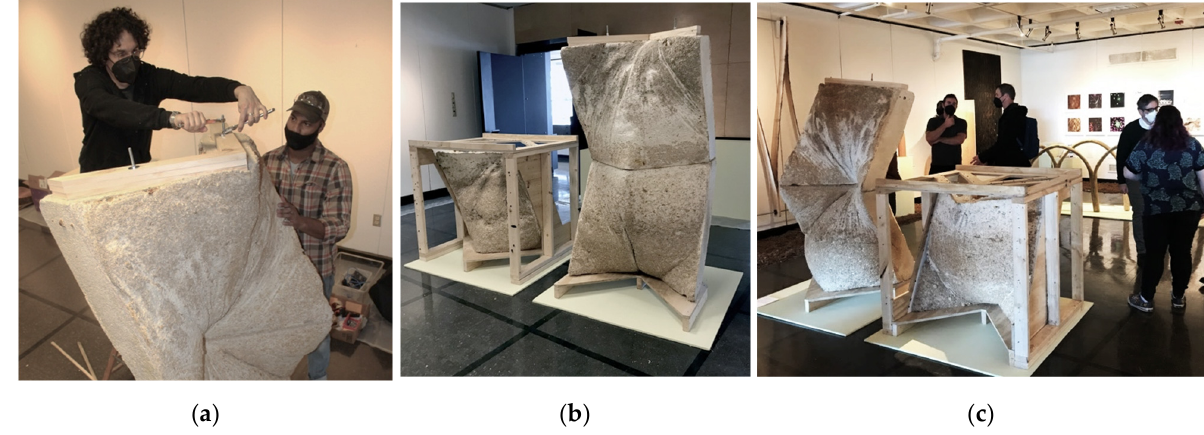
Figure 15. Post-tensioning and exhibiting the prototype: ( a ) tightening the internal cables to add compressive force to the assembly; ( b ) gallery installation with stacked units and wood formwork; ( c ) wall prototype during exhibition opening at the UVA. Photos by the author and Leila Ehtesham.